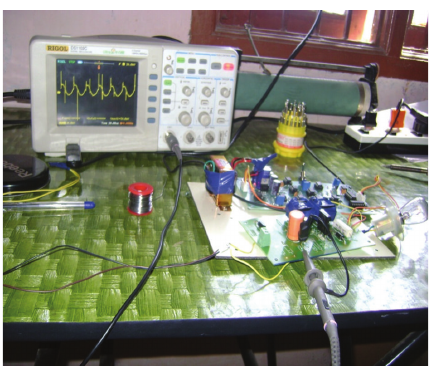
Figure 6: Hardware setup.